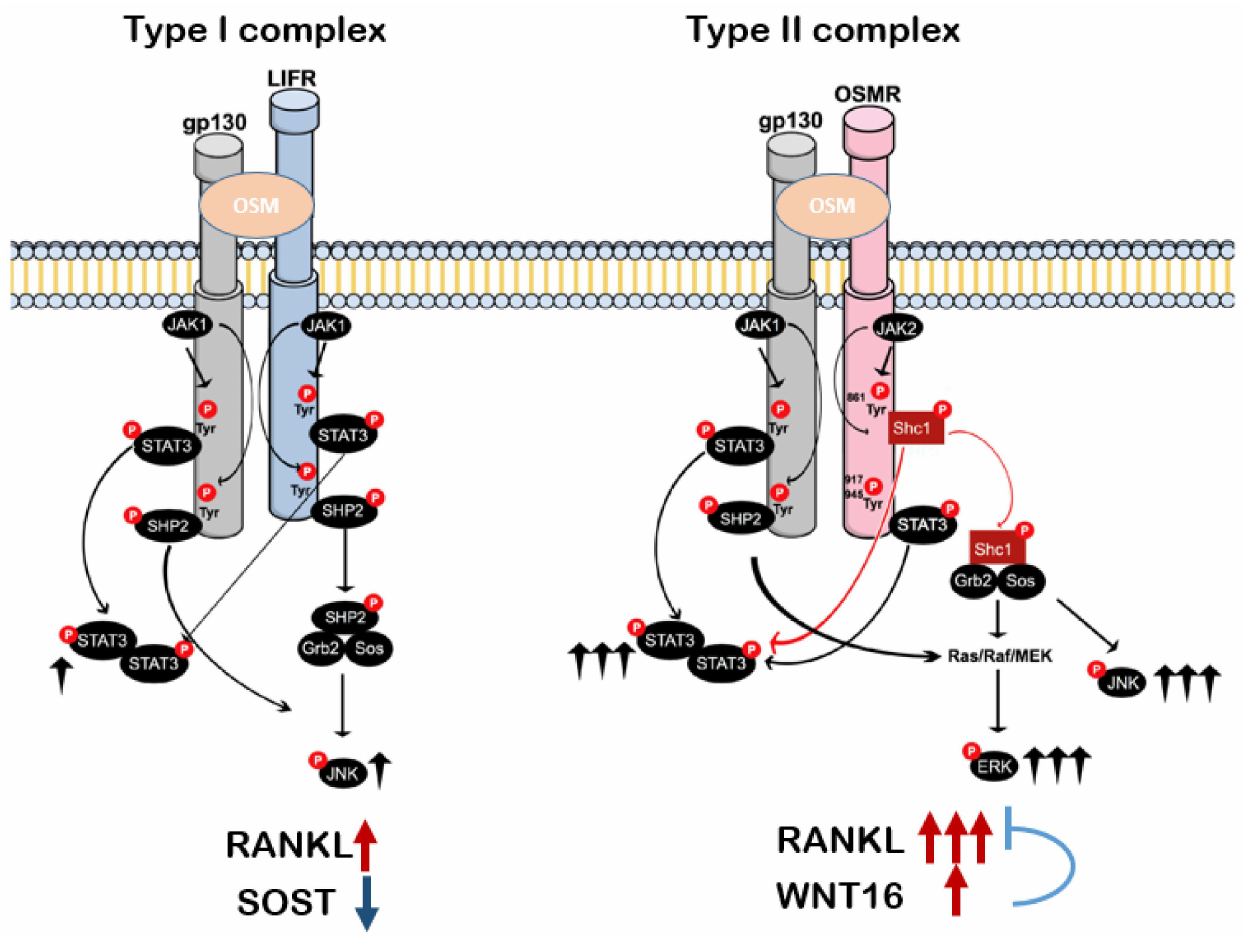
Figure 4. Schematic representation of OSM-induced signaling pathways in osteoblasts. OSM binding to the type I receptor complex activates STAT3 and JNK and regulates RANKL and sclerostin (SOST) expression. In addition to the gp130-mediated pathways common for LIFR and OSMR, the OSM receptor binding to the type II complex phosphorylates OSMR on Tyr 861 , resulting in docking and phosphorylation of the adapter molecule Shc1. The activated pShc1 is recruited to the Grb2:Sos complex, which in turn induces a Ras/Raf/MAPK cascade that ultimately activates ERK. The Shc1- mediated signaling pathway ( right ) is suggested to explain the stronger effects of OSM on expression of osteoclastogenic factors, osteoclast formation and bone resorption in comparison to activation of the LIFR:gp130 complex by LIF ( left ). This pathway also regulates Wnt16 expression that suppresses RANKL-induced osteoclastogenesis. Figure slightly modified from Persson et al. [60]. Copyright © 2019 Persson, Souza, Floriano-Marcelino, Conaway, Henning and Lerner. Licensed under a CC BY 4.0